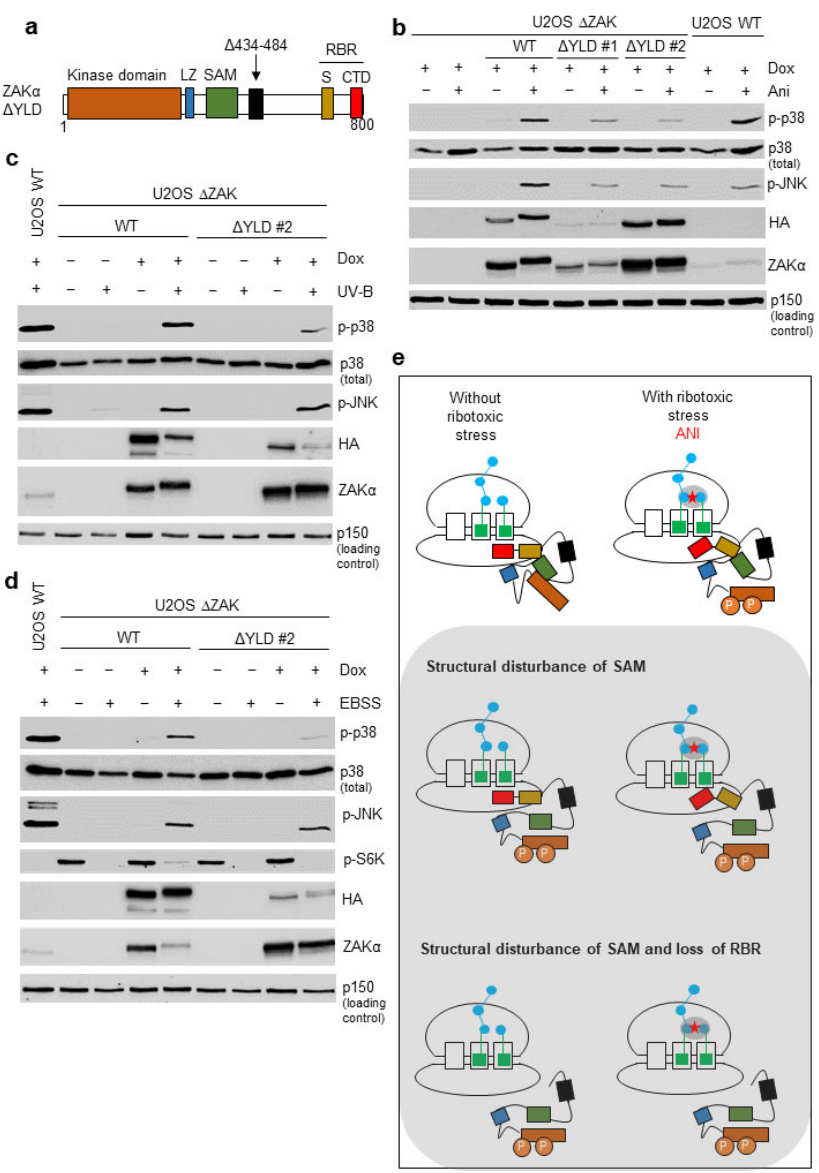
Figure 5. Disruption of the YLD decreases the activation potential of ZAK α . ( a ) Schematic of the ZAK α ∆ YLD mutant protein, indicating a deleted region within the YLD domain. ( b ) U2OS ∆ ZAK cells were rescued with either wildtype (WT) ZAK α or ZAK α ∆ YLD, of which two clones with different expression levels were analyzed ( ∆ YLD #1 and #2). Cells were induced for expression with doxycycline (Dox) and treated with anisomycin (Ani—10 µ g/mL, 1 h). Lysates were analyzed by immunoblotting with the indicated antibodies. ( c ) Cells from ( b ) were irradiated with UV-B (500 J/m 2 —1 h) and analyzed as in ( b ). ( d ) Cells from ( b ) were incubated in EBSS medium (18 h) and analyzed as in ( b ). ( e ) Model of ZAK α activation by ribosome impairment, here caused by binding of anisomycin (ANI) to the peptidyl transferase center. The SAM domain inhibits activation whereas the kinase scans ribosomes (top panel—left). This inhibition is relieved upon recognition of ribotoxic stress signals by the C-terminal S and CTD domains (top panel—right). Kinase activation is signi fi ed by ZAK α autophosphorylation (P). Upon mutation of the SAM domain, sensing of ribotoxic stress by the RBR region (S + CTD) is not required for ZAK α activation (middle and bo tt om panels). ZAK α domains are color-coded as in ( a ). LZ, Leucine Zipper; SAM, Sterile Alpha Motif; YLD, YEATS-Like Domain; S, Sensor Domain; CTD, C-Terminal Domain; RBR, Ribosome Binding Region; and p-, phosphorylated (activated) form of kinase.